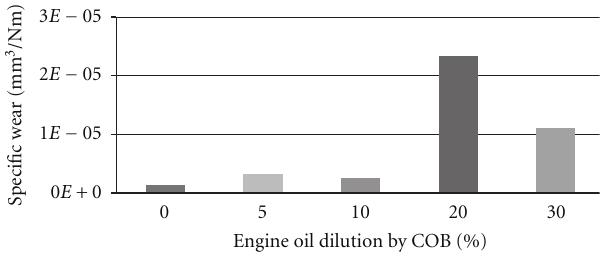
Figure 2: Specific wear for canola-oil biodiesel (COB) diluted engine oil mixtures.